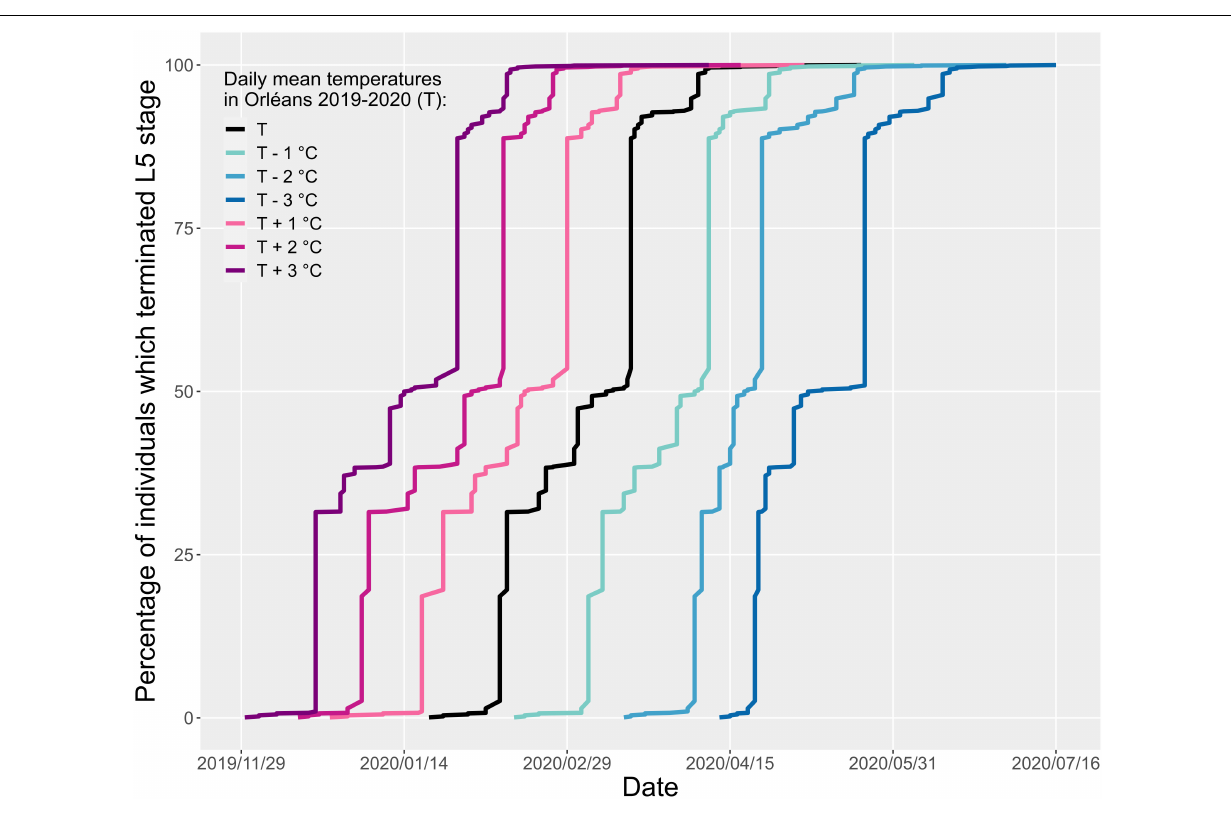
FIGURE 7 | Predicted cumulated percentage of individuals that completed larval development (end of L5) over time, depending on simulated variations of the daily mean temperature in Orléans. This graph represents the times of end of L5 development, depending on arbitrary decrease or increase of temperature. The temperature baseline considered here is the daily mean temperature recorded in Orléans in